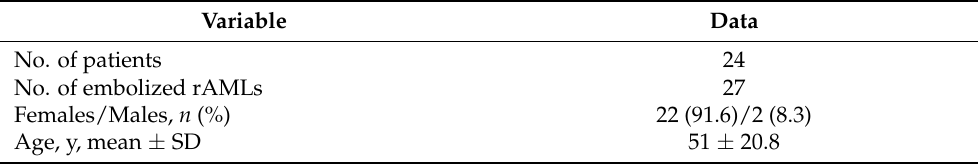
Table 1. Mean features of the 24 study patients (27 renal angiomyolipomas